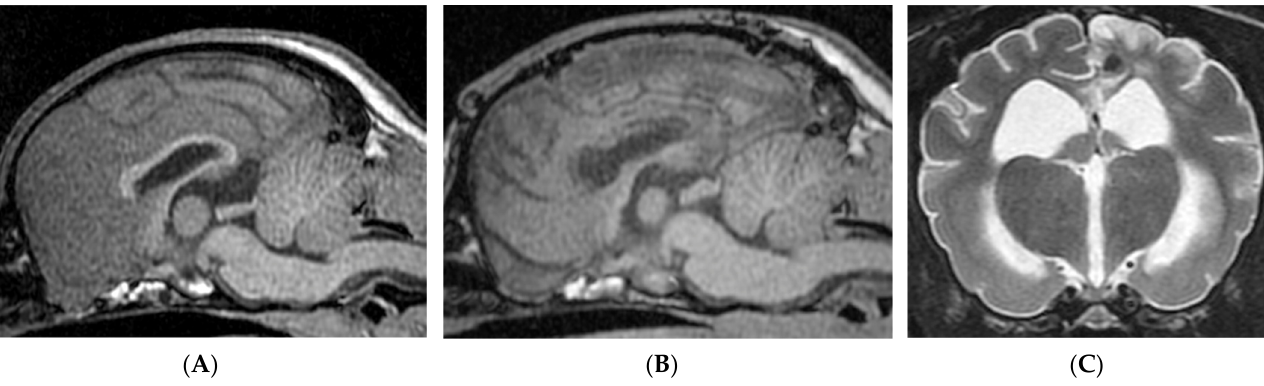
Figure 4. Preoperative ( A ) and postoperative 12 months ( B , C ) MRIs in Case 2. Predisposed Chiari-like malformation was observed (( A , B ) midline sagittal T1-weighted). Total CC was performed in this case ( B ), but hemosiderosis was observed around the vein of the corpus callosum. In this dog, however, delayed focal infarction in the cingulate to marginal gyrus of the left parietal lobe was observed at 6 months after surgery (( C ) transverse T2-weighted).